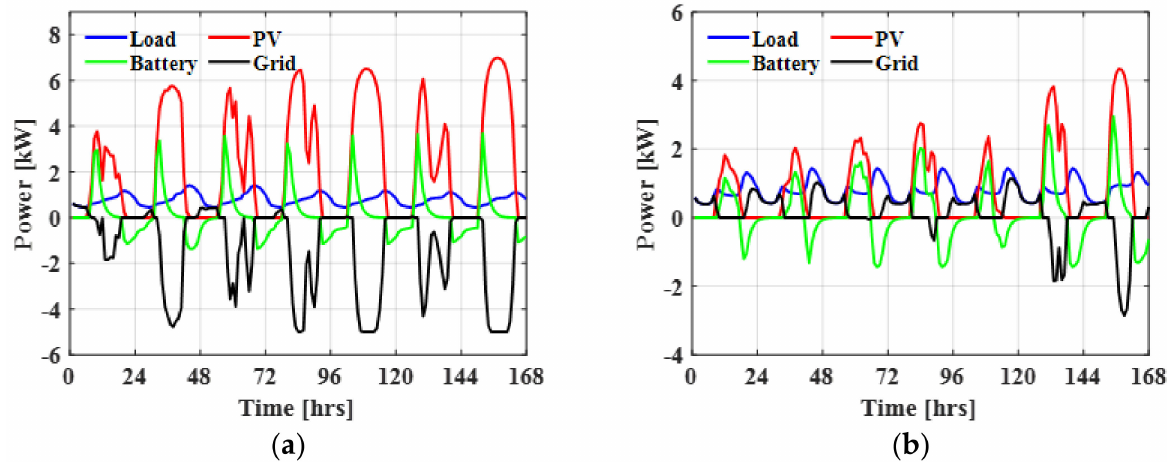
Figure 7. Weekly power flow of the household under Flat-Flat rates: ( a ) Summer week, and ( b ) Winter